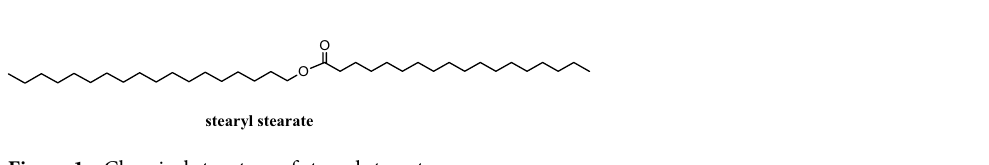
Figure 1. Chemical structure of stearyl